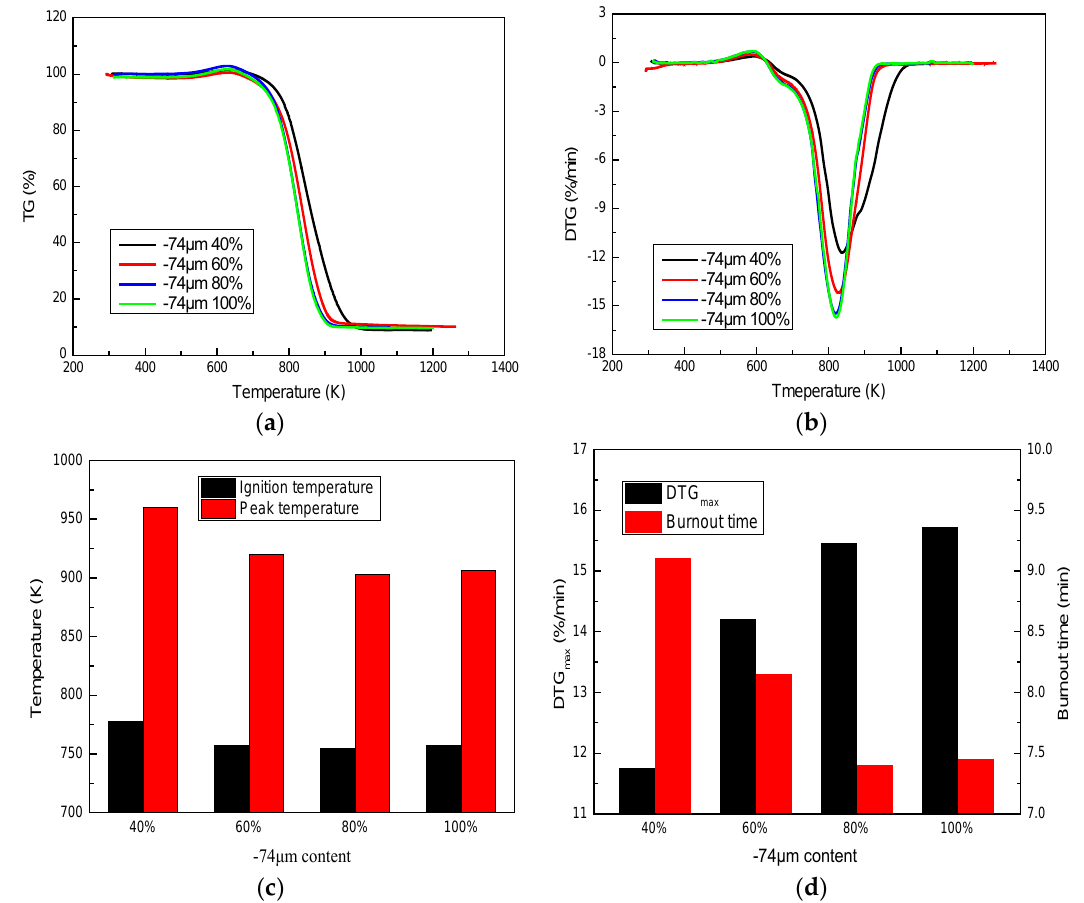
Figure 4. Effect of size on coal combustion: ( a ) TG profile; ( b ) DTG profile; ( c ) and ( d ) Coal combustion characteristics.